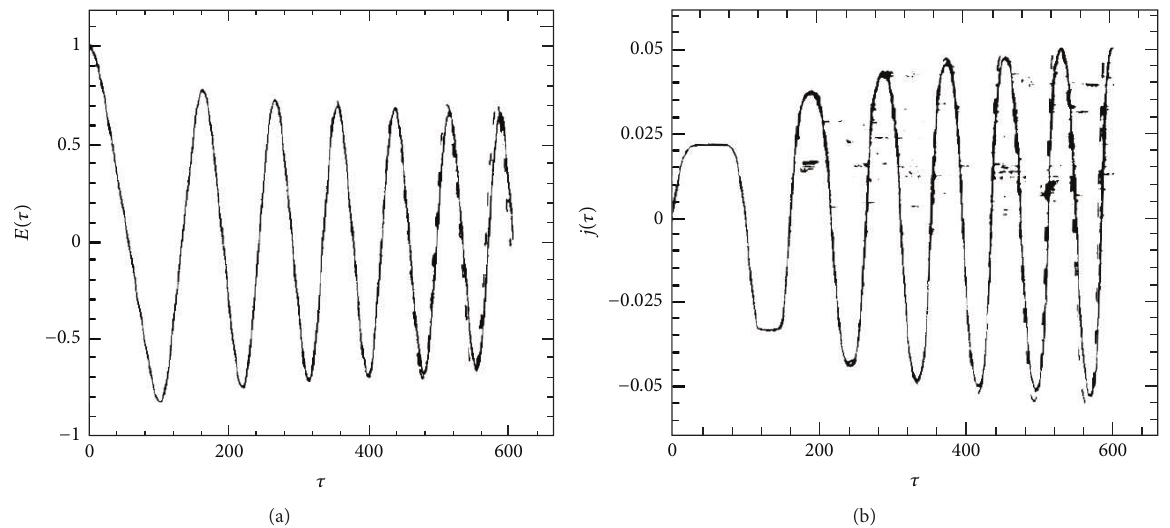
Figure 5: Time dependence of electric field due to the Schwinger mechanism back reaction and the corresponding electric current density of Schwinger pairs. Dimensionless time variable is defined as 𝜏 = 𝑡/𝜆 . For electrons 𝜆 = 380 fm. Plasma undergoes phase transition at about 𝜏 = 1/38 . Adapted from